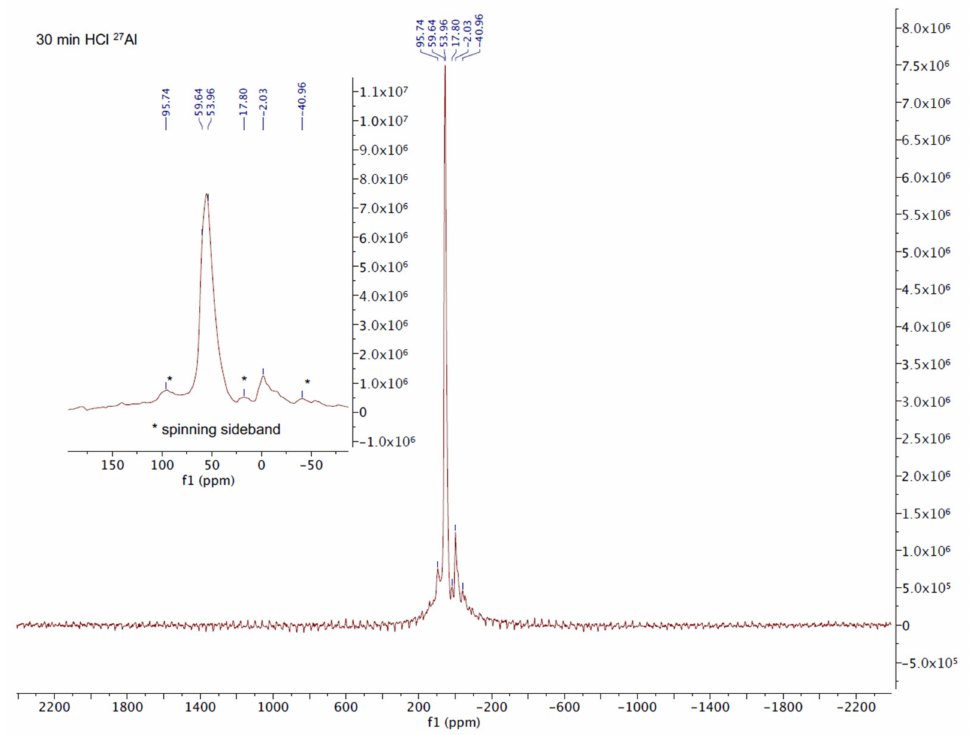
Figure 10. The 27 Al NMR of 30 min HCl NV-Na externally referenced to 1 M Al(NO 3 ) 3 at 0.0